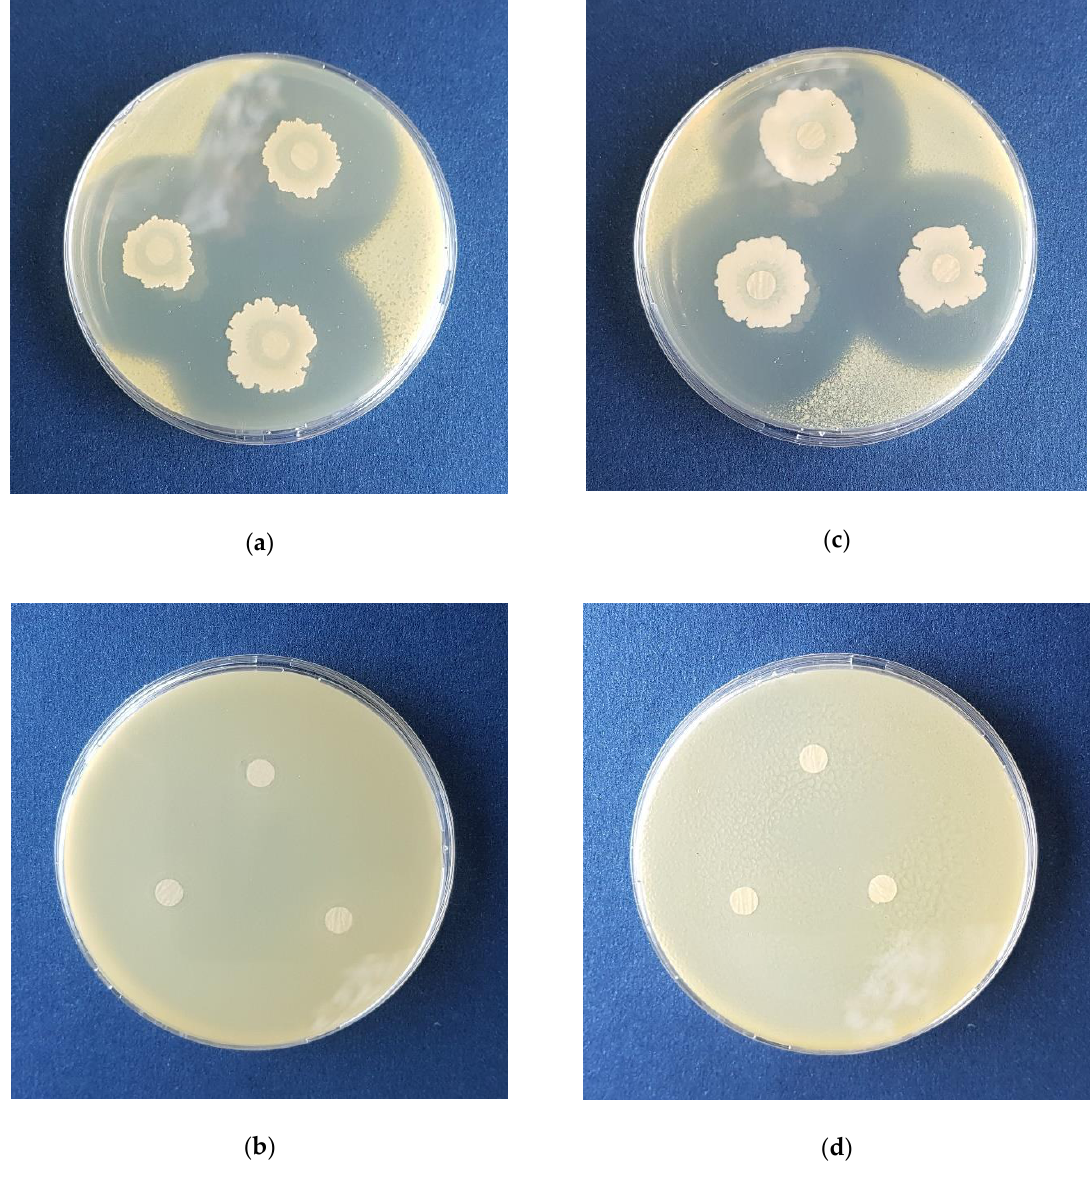
Figure 6. Inhibition zone diameters obtained as a result of in vitro antimicrobial activity testing against X. euvesicatoria : ( a ) cultivation broth sample from the end of the validation experiment against X. euvesicatoria PL1, ( b ) negative control— X. euvesicatoria PL1, ( c ) cultivation broth sample from the end of the validation experiment against X. euvesicatoria PL2, ( d ) negative control— X. euvesicatoria